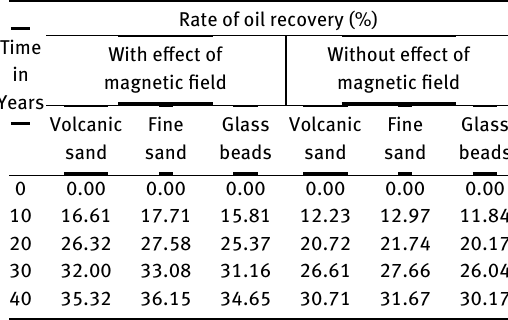
Table 8: Numerical values of recovery rate in various types of frac- tured porous medium